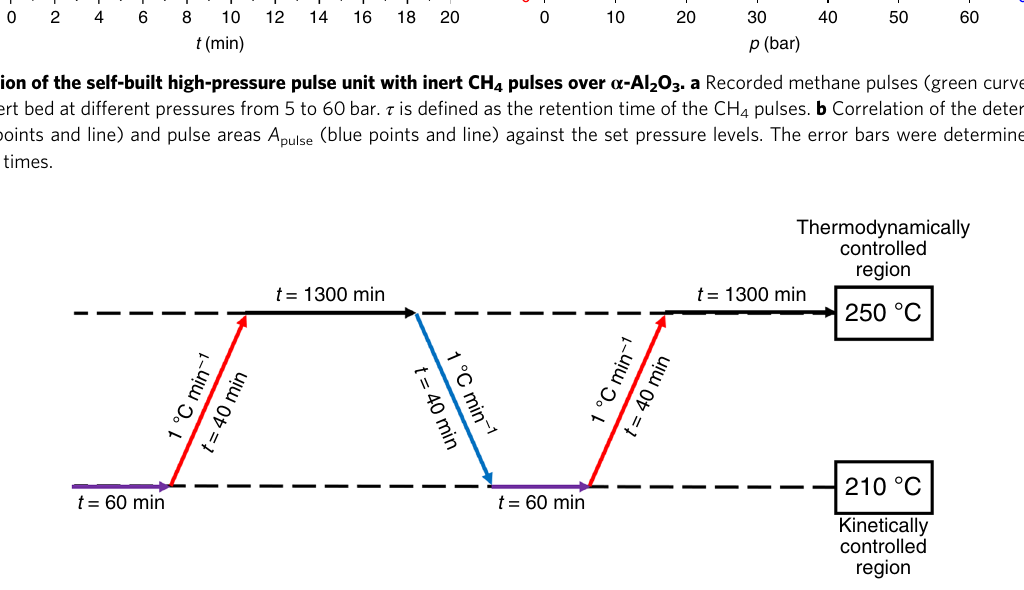
Fig. 7 Experimental protocol of the long-term measurement adapted from the studies by Fichtl et al. 18 . The violet arrow describes the period of time to record the kinetic data point, the red arrow describes the heating rate, the black arrow describes the aging of the catalyst bed under equilibrium conditions and the blue arrow describes the cooling